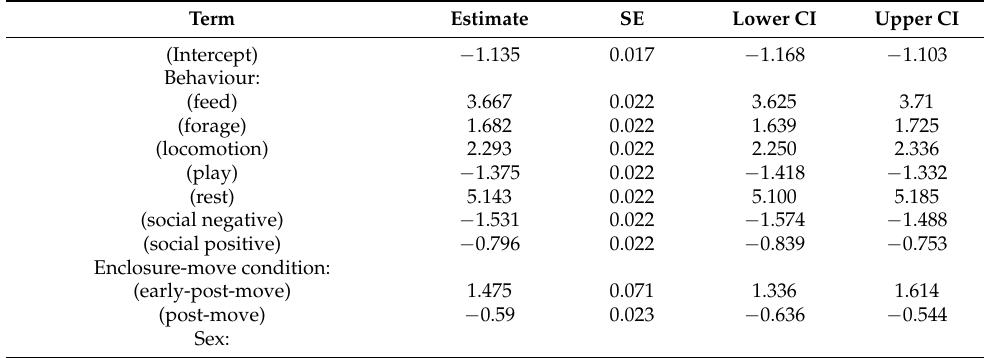
Table A8. Model 4 summary output: Malayan tapir activity